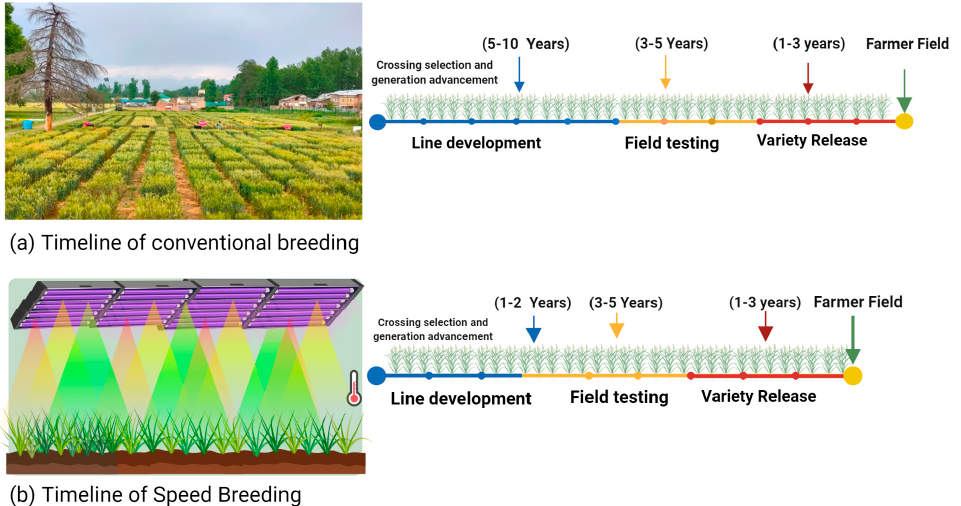
Figure 1. Timelines of varietal development with ( a ) conventional breeding and ( b ) speed breeding. The image was created using BioRender (https://biorender.com/ accessed on 20 January 2022).